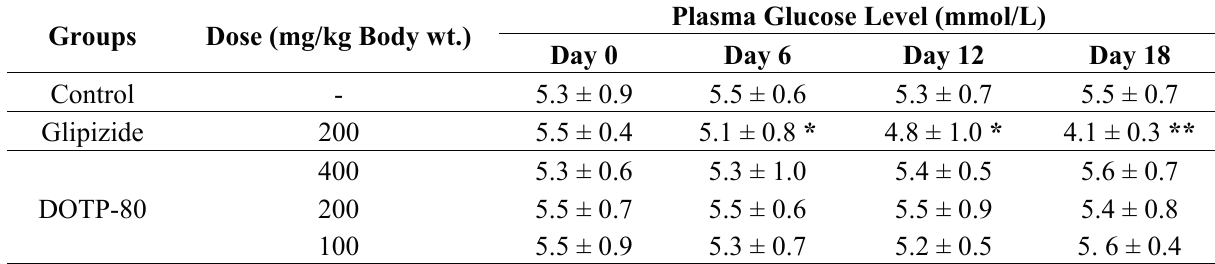
Table 1. Effects of DOTP-80 on plasma glucose level of normal